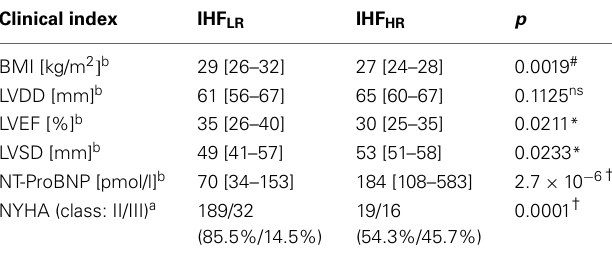
Table 1 | Clinical indices: univariate statistical analysis results ( U -test) to discriminate between patients with ischemic heart failure at low risk and at high risk (IHF LR and IHF HR